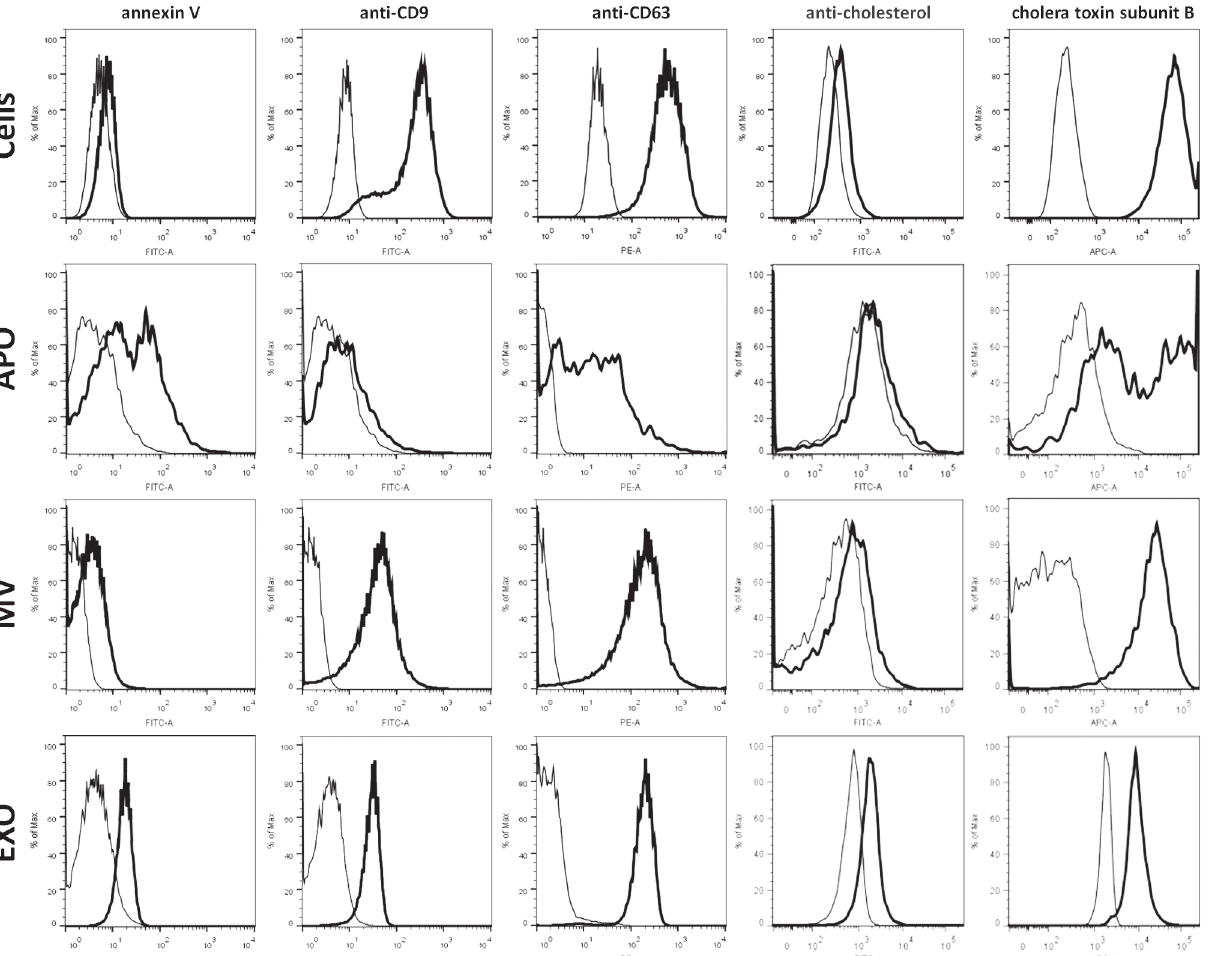
Fig 2. Flow cytometric characterization of EV subpopulations. EV subpopulations were isolated from BV-2 cells, and were analyzed along with the releasing cells either directly (MVs and APOs) or after coupling to latex beads (EXOs) by flow cytometry using annexin V FITC, as well as anti-CD9 FITC, anti-CD63 PE and anti-cholesterol CF488-conjugated antibodies, and Alexa Fluor647-conjugated cholera toxin (CTX) (all marked with thick black lines), and were compared to respective negative controls (thin black lines). Isotype controls were used for samples stained with fluorochrome-conjugated antibodies, whereas autofluorescence was detected in the absence of either annexin V or CTX. Images and figures are representatives of at least three independent experiments.